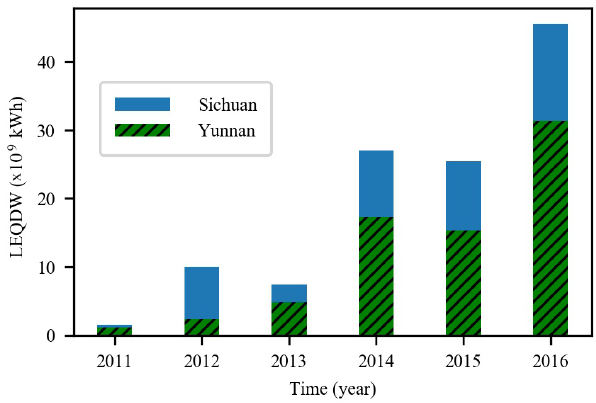
Figure 1. Losses of electric quantity due to discarded wa- ter (LEQDW) in Sichuan and Yunnan